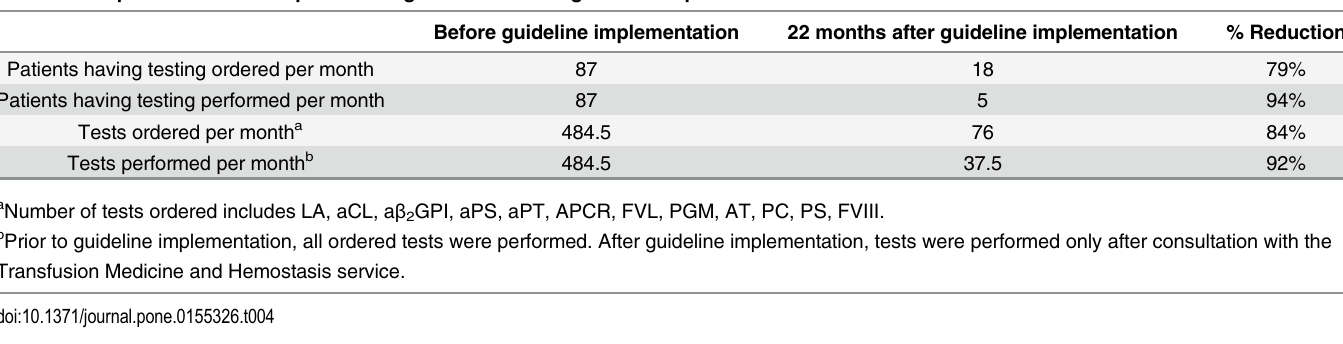
Table 4. Comparison of thrombophilia testing before and after guideline